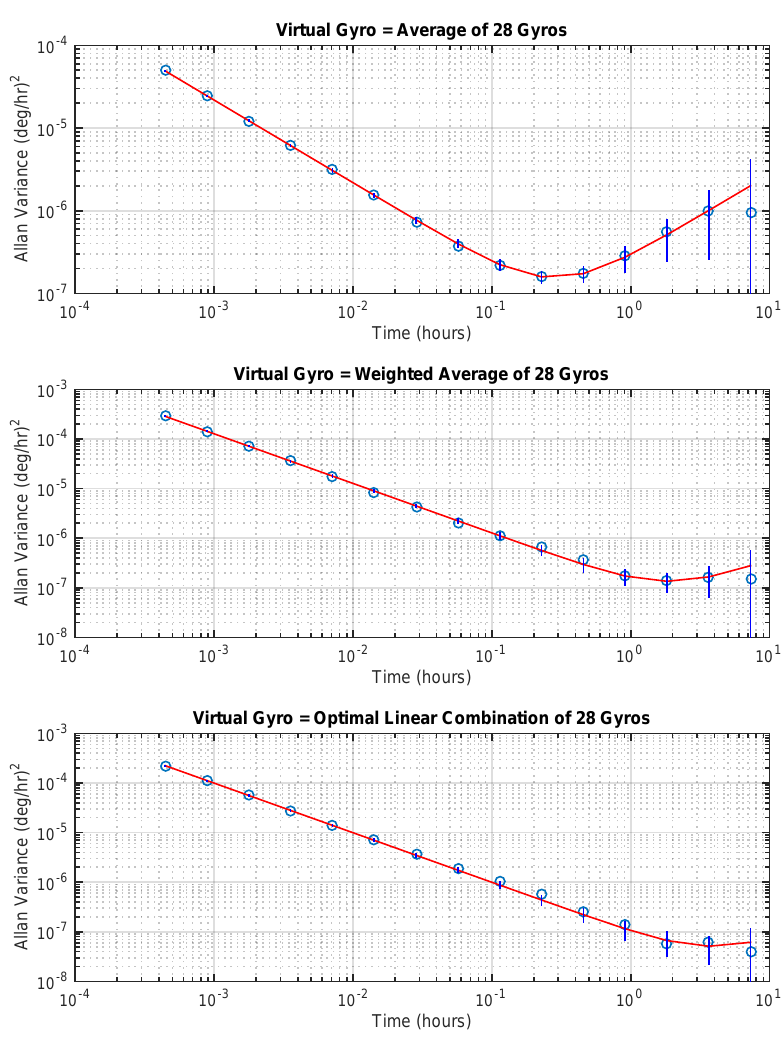
Figure 3. Allan variance plots for virtual gyros. Circles are calculated Allan variance points. Smooth curves are theoretical Allan variance plots corresponding to the ( ˆ R , ˆ Q ) obtained for each virtual gyro using Algorithm 1. Vertical lines through each point are ± 2 standard deviations calculated using ( ˆ R , ˆ Q ) . ( Top plot ): average of 28 gyros. ( Middle plot ): weighted average of 28 gyros using only diagonal elements of ˆ Q . ( Lower plot ): optimal linear combination of 28